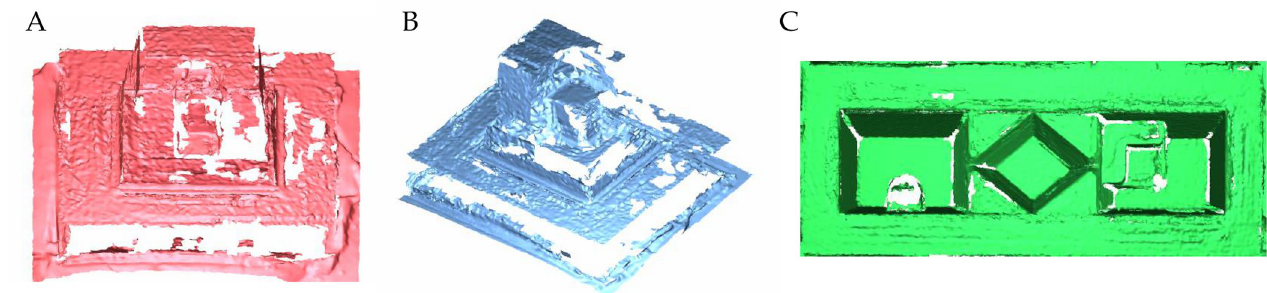
Fig 3. 3D superimposition color maps of three experimental groups in three reference models. A—inlay model; B—onlay model; C—bridge model (tolerance range ± 30 μ m).